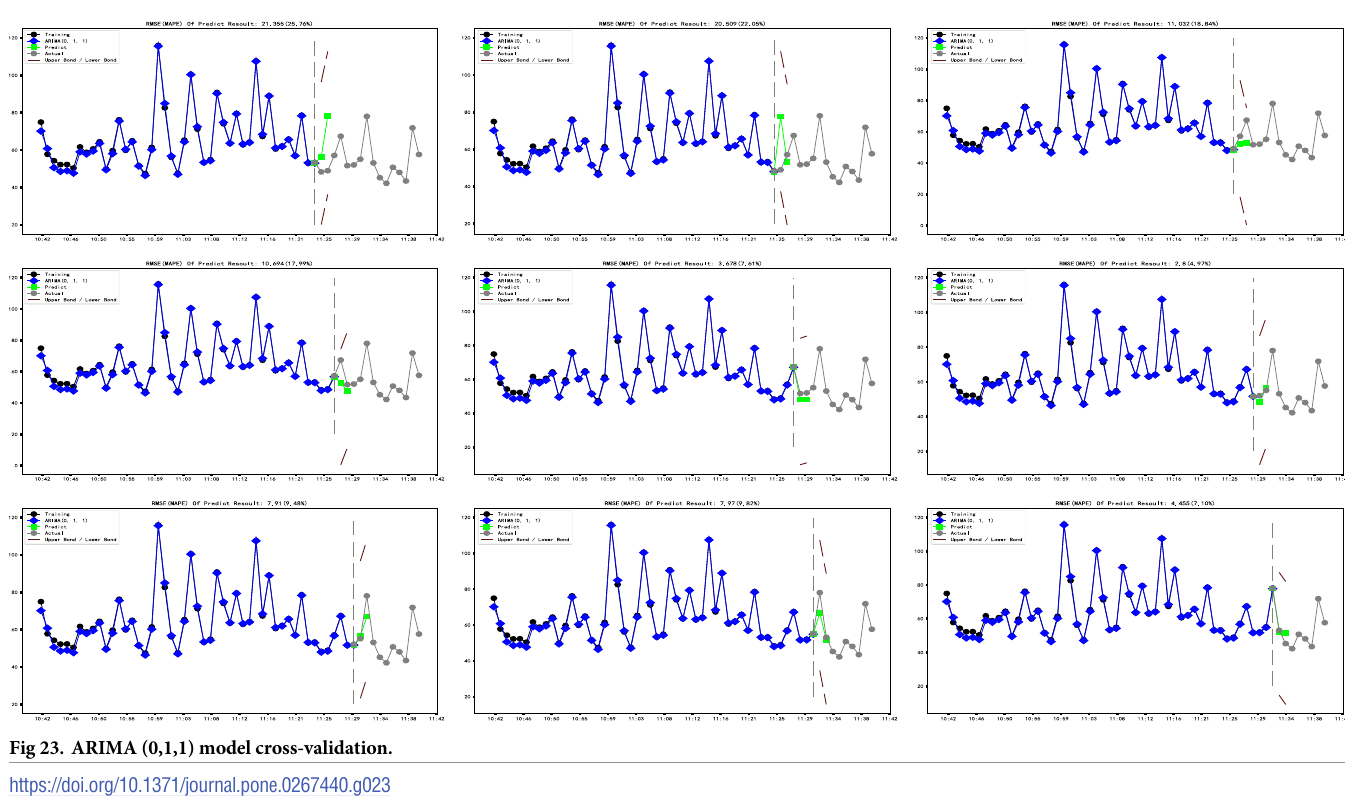
Fig 23. ARIMA (0,1,1) model cross-validation.